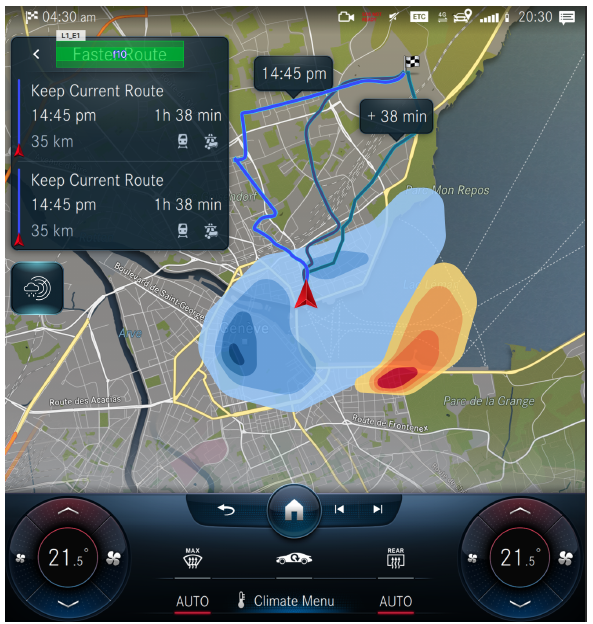
Figure 6. Example of rain cloud (blue) and snow (yellow red) shapes on a navigation